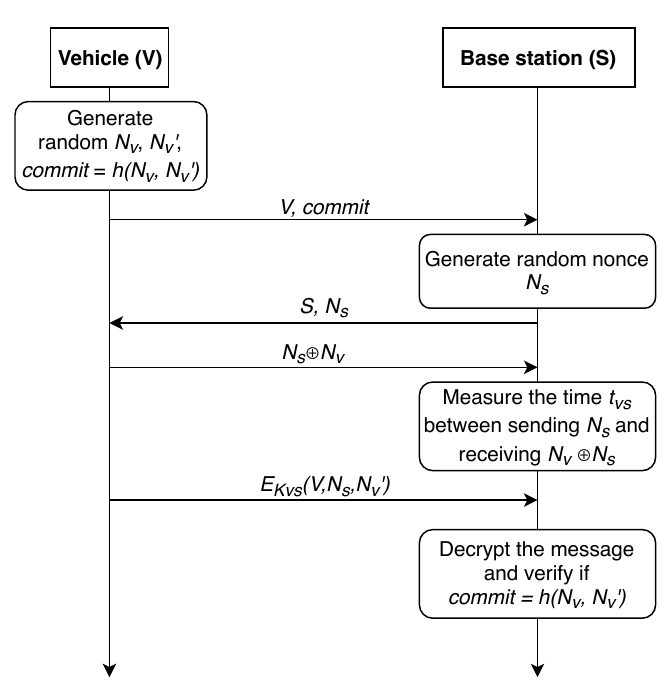
Figure 4. An improved distance-bounding P-06-M protocol.